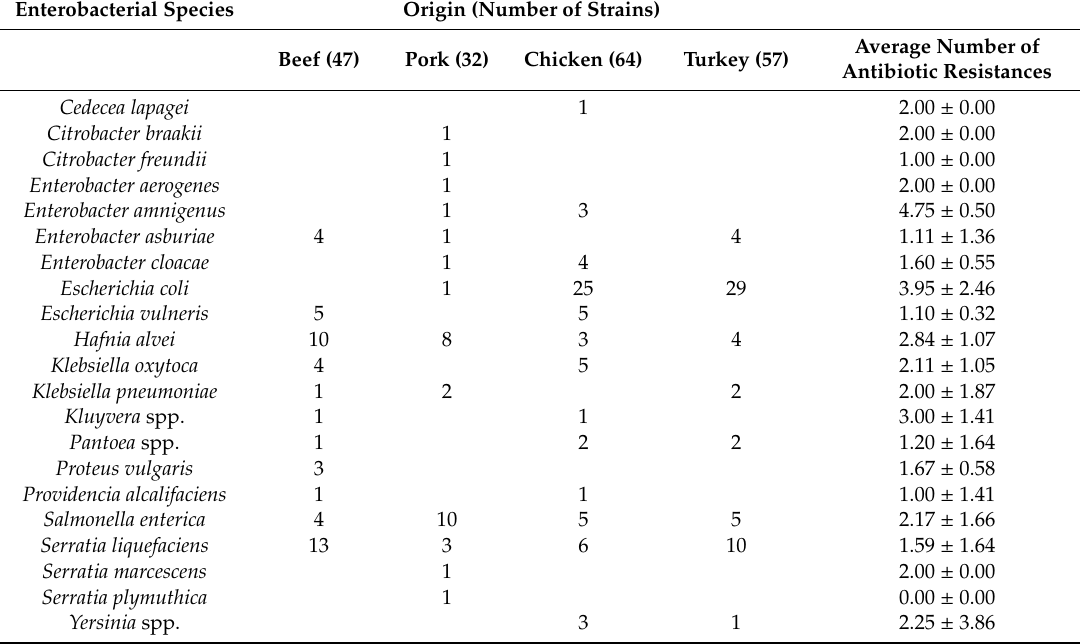
Table 1. Identification and origin (animal species) of 200 enterobacteria strains isolated from red meat and poultry preparations.